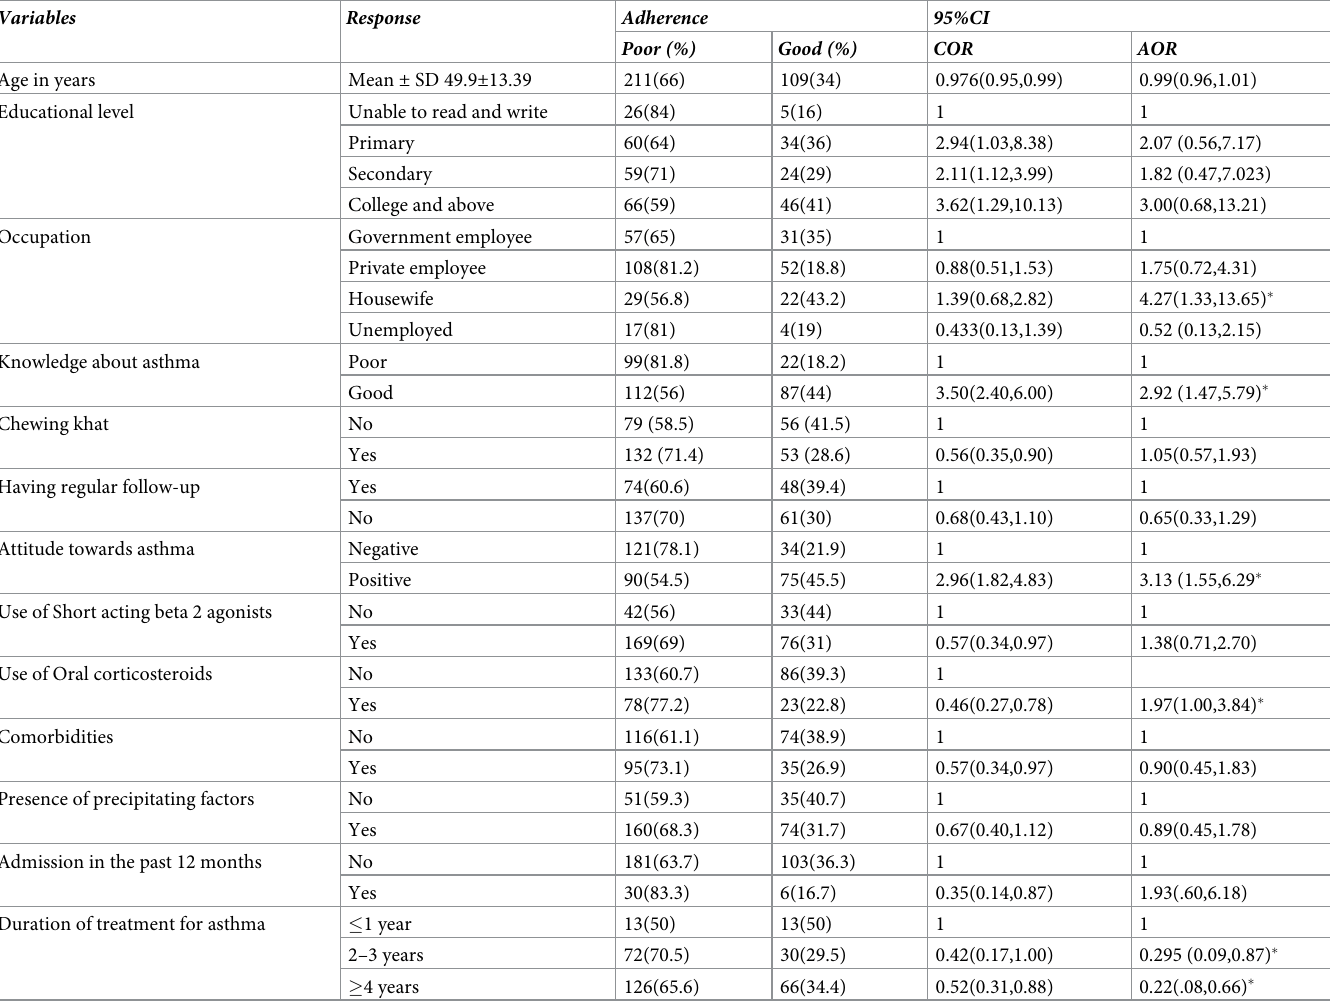
Table 4. Factors associated with adherence to anti-asthmatic medications among study